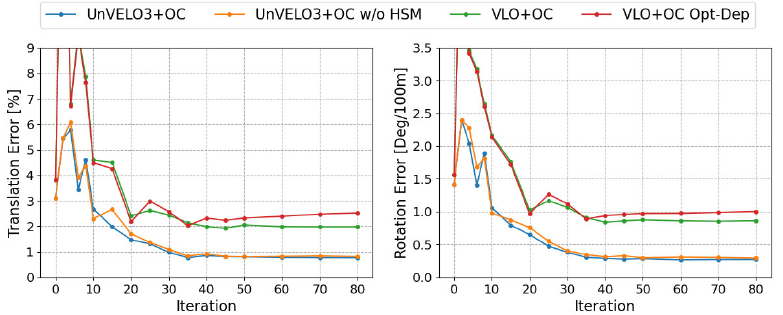
Figure 5. The performance of different model variants varied with respect to different iteration numbers. The translation and rotation errors are the mean errors of sequences 09 and